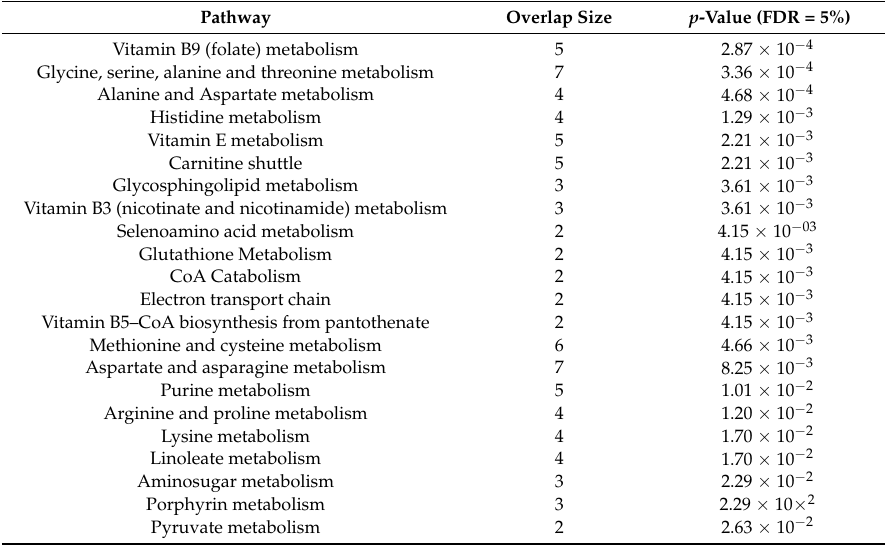
Table 2. Significantly dysregulated pathways.